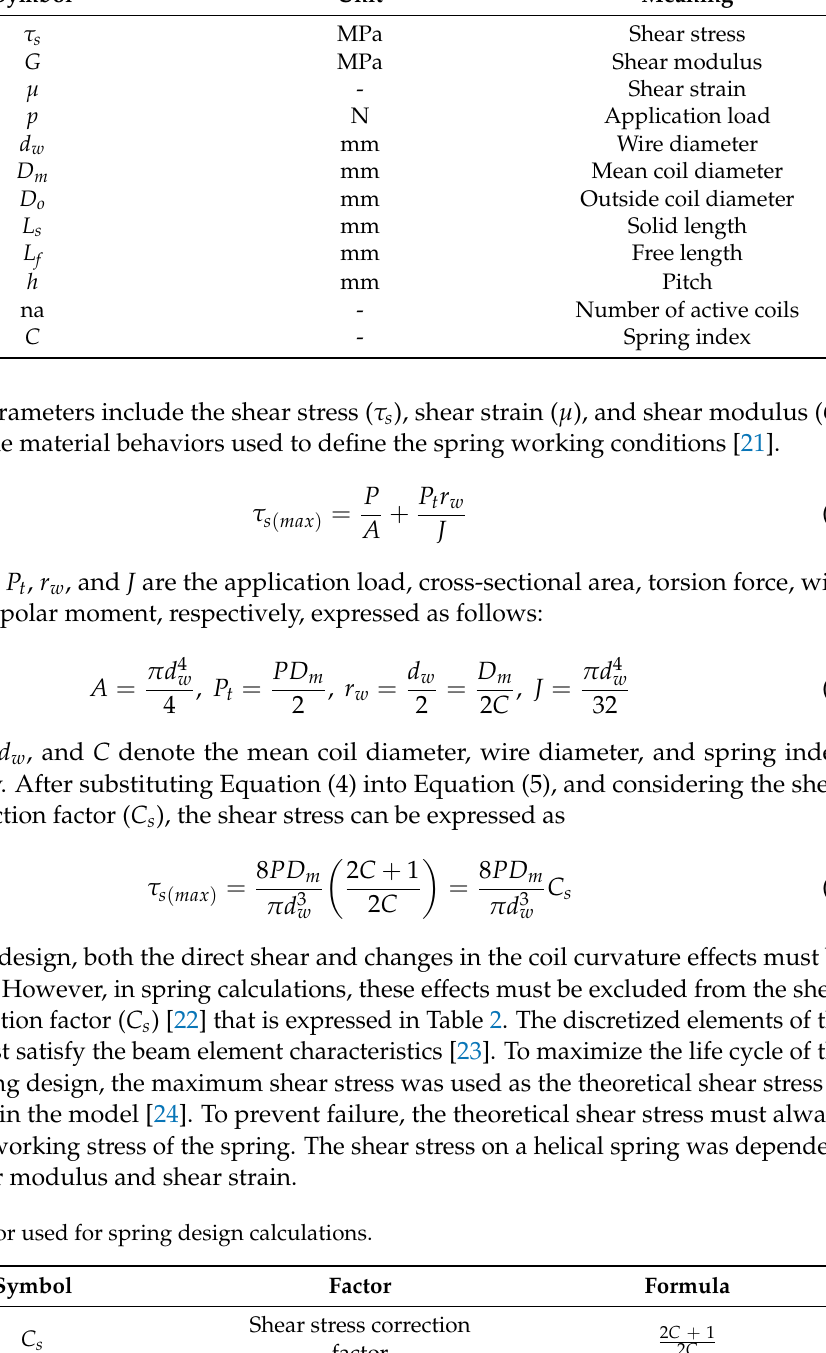
Table 1. Design parameters of coiled helical spring. Symbol Unit